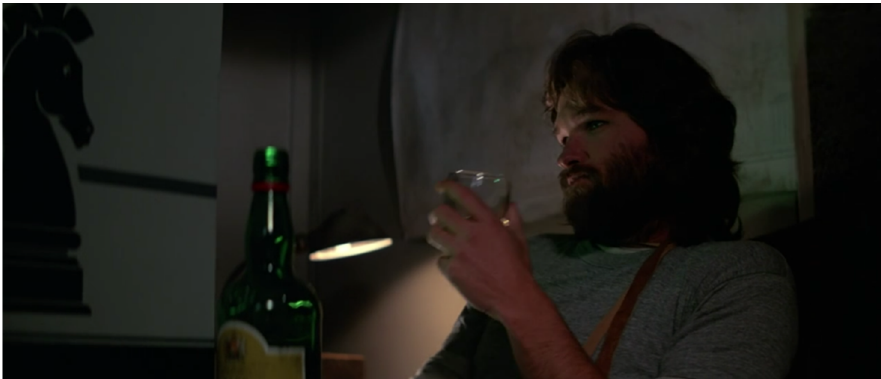
Figure 2. MacReady plays Chess Wizard in The Thing (1982). (Screenshot created by author).